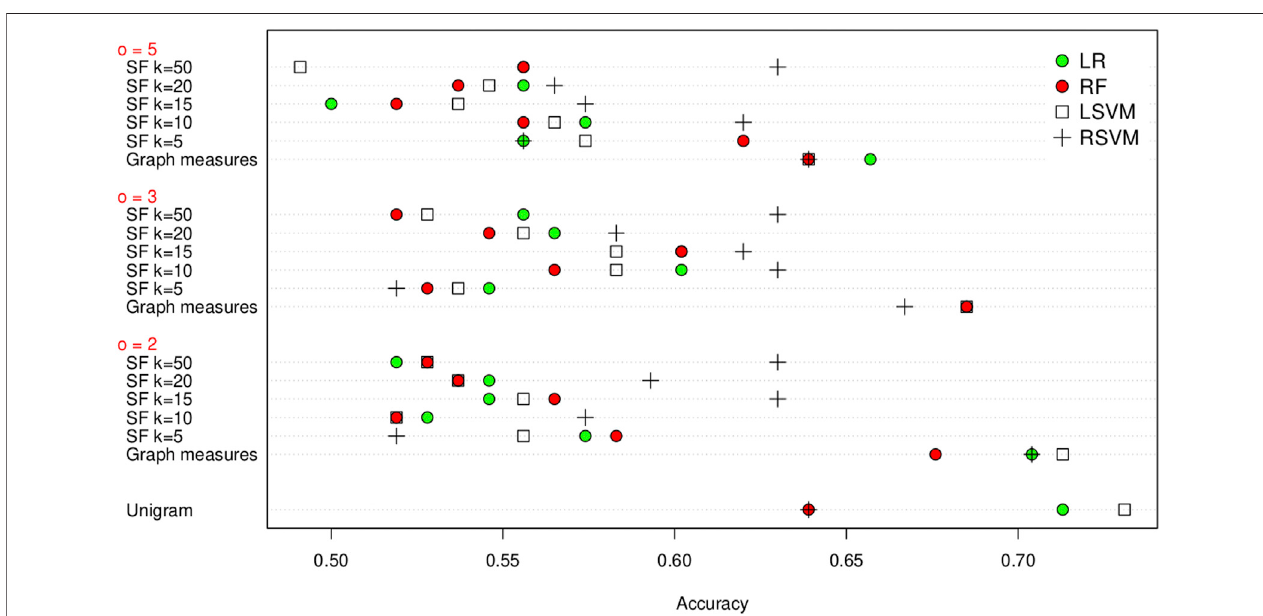
FIGURE 2 | Classi fi cation accuracy of the unigram, graph measures and SF feature extraction methods on the training set using leave one out cross validation, grouped by co-occurrence window size ( o ∈ { 2 , 3 , 5 } ). The best result of 71.3% is achieved using a linear SVM on the graph measures with a co-occurrence window of 2 ( o (cid:2) 2).